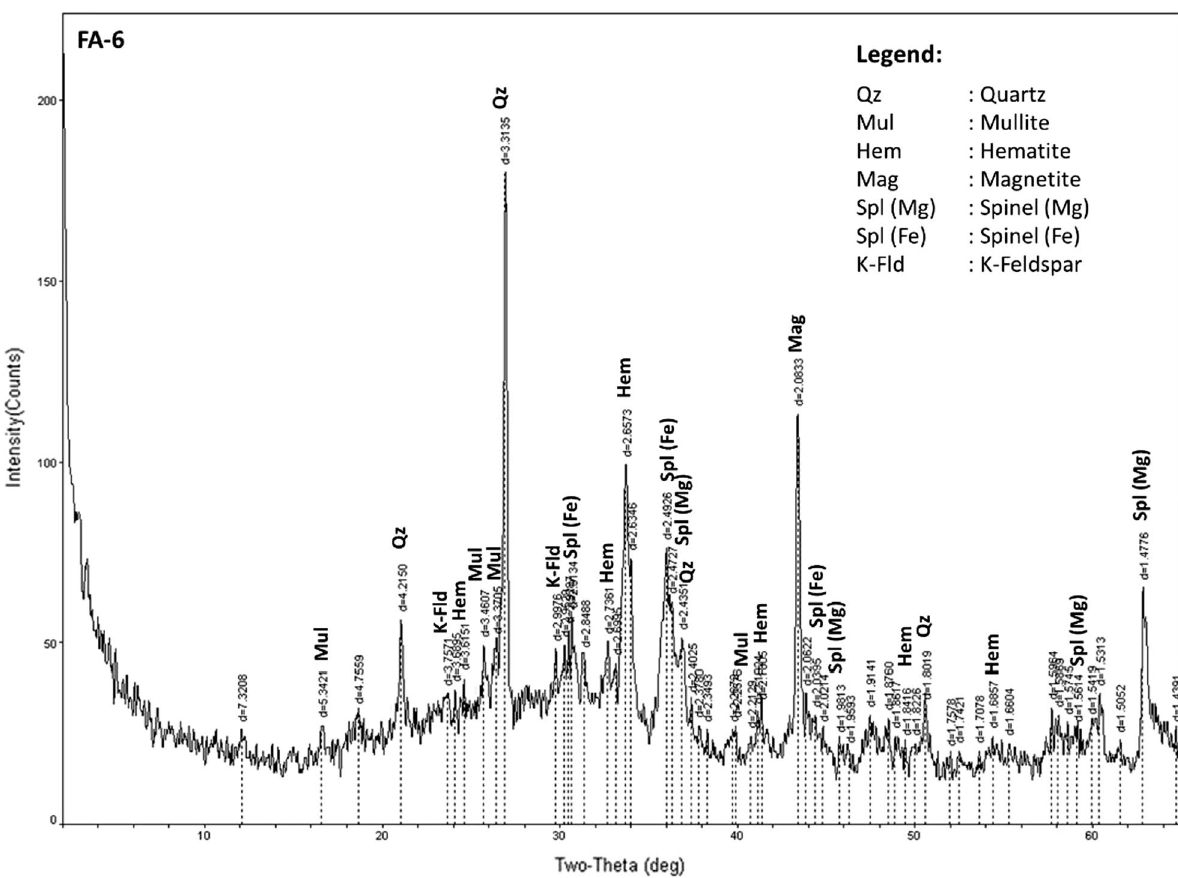
Fig. 9 X-ray diffraction spectrum for sample fly ash FA 6 showing peaks for the existence of quartz, mullite, k-feldspar, hematite, magnetite, Fe- spinel, and